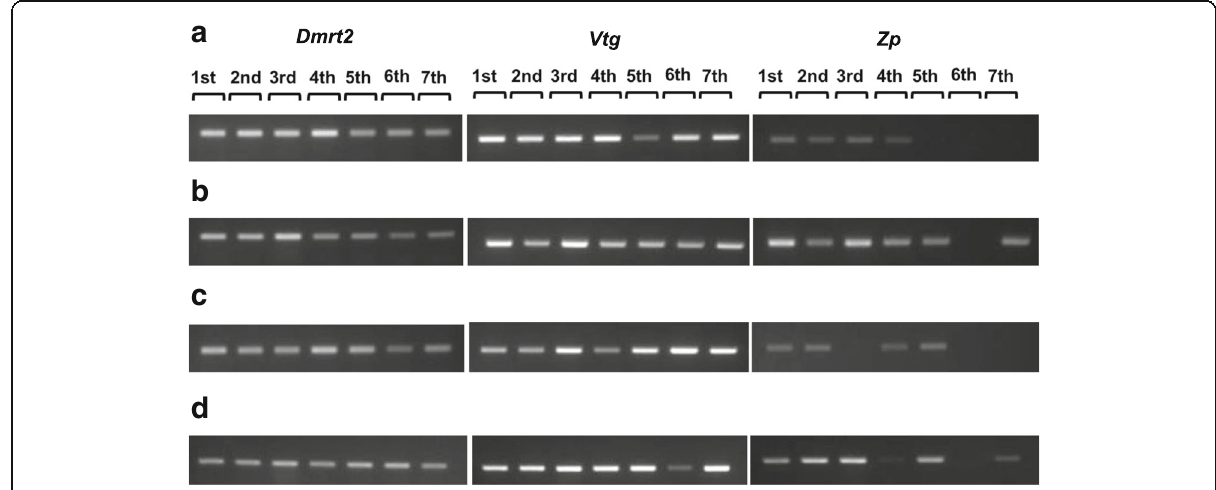
Fig. 4 RT-PCR analysis of Akoya pearl oyster ( P. fucata ) Dmrt2 , Vtg and ZPB at seven sampling times. ( a ) AM: all-period male; ( b ) AF: all-period female; ( c ) FM: female changed to male; ( d ) MF2: changing between male and female. 1st-7th: sequence of sampling time